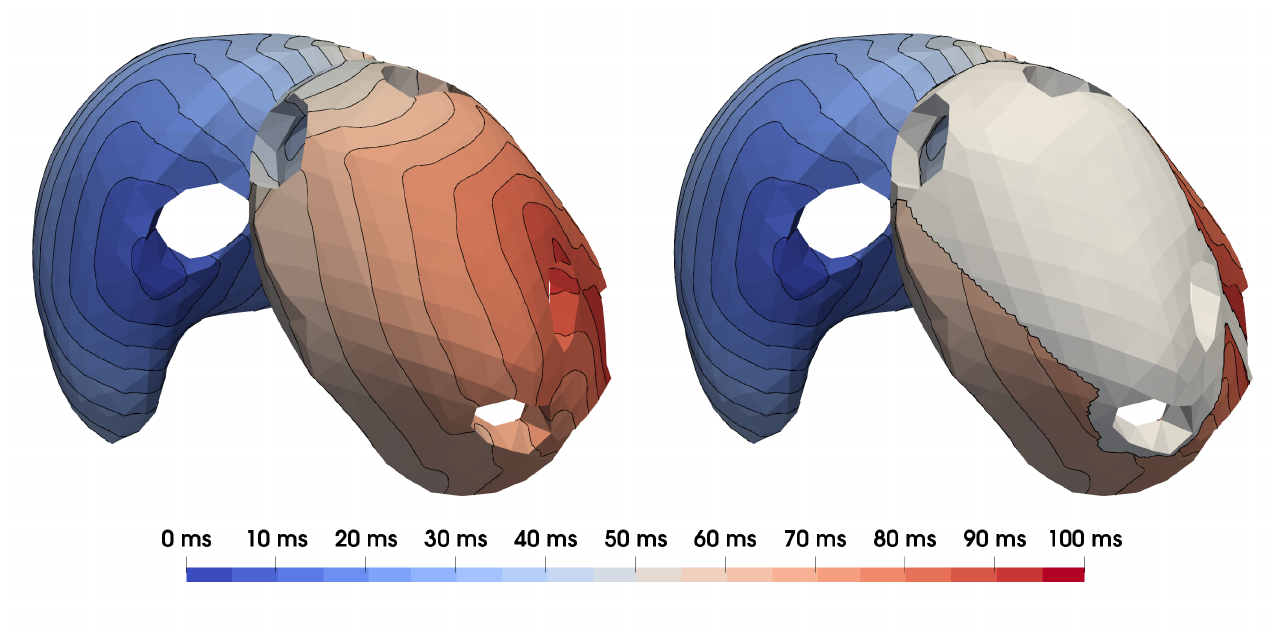
Figure 13. Atrial local activation times from the reference simulation (left) and the simulation including an ablation scar in the left atrium